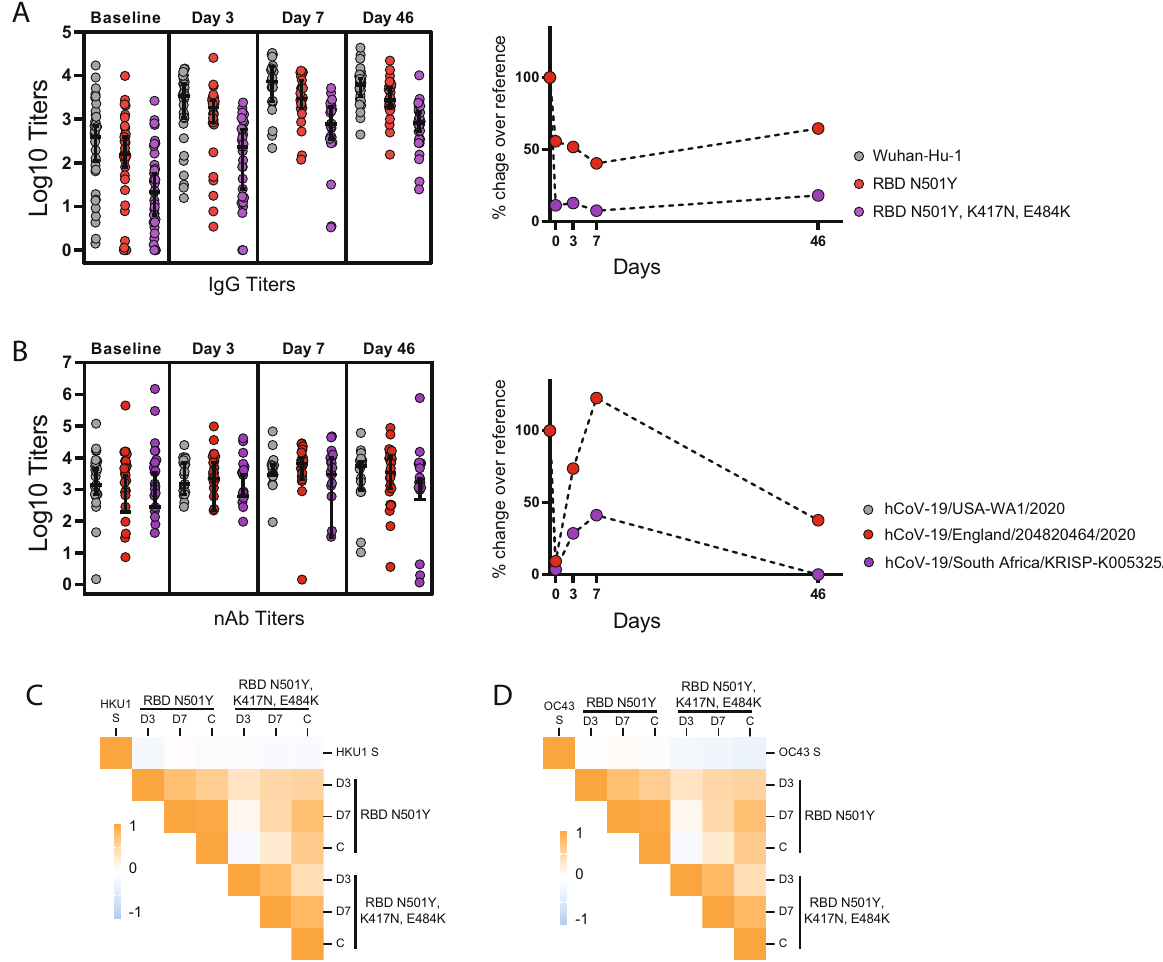
Fig. 8 Imprinting and antibody response against emerging variants of SARS-CoV-2. A ELISA against the receptor-binding domains (RBDs) of Wuhan- Hu-1 (reference), and mutated RBDs representative of UK (N501Y) and South African (K417N, E484K and N501Y) variants. B Neutralizing titers against the authentic hCoV-19/England/204820464/2020 (B.1.1.7) and hCoV-19/South Africa/KRISP-K005325/2020 (B.1.351). Errors indicate geometric